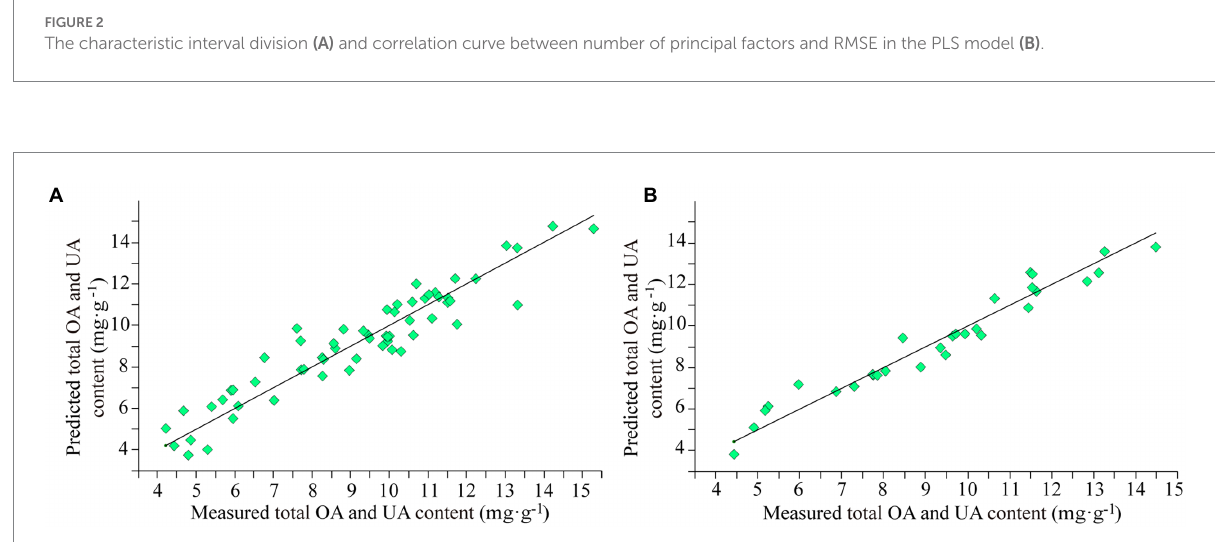
FIGURE 3 The results of model M10 for the total content of OA and UA. (A) Internal cross-validation and (B) external